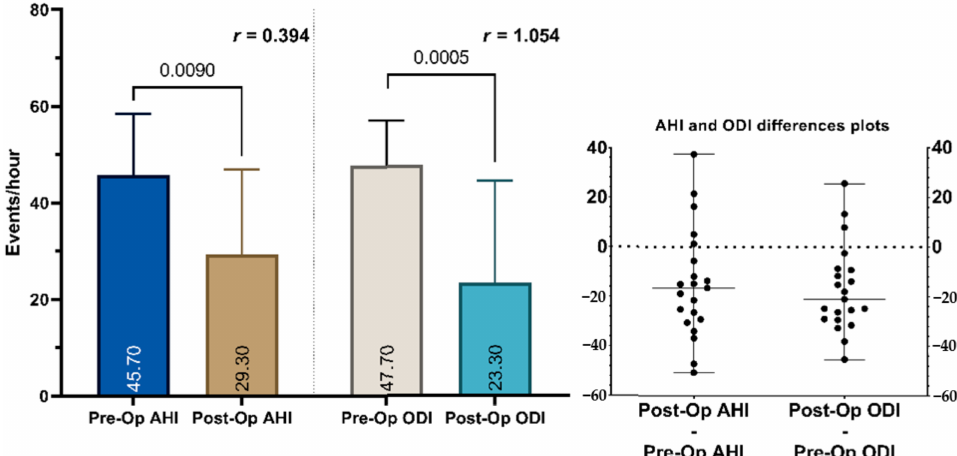
Figure 5. On the left side: a pre- and post-operative comparison of the apnea-hypopnea index and the oxygen desaturation index median and interquartile range values. The median values are shown inside the columns and the p -value is shown above the columns. The effect size ( r -value) is shown above the columns. On the right side: differences plot for the AHI and ODI of individual patients. AHI: apnea-hypopnea index; ODI: oxygen desaturation index.